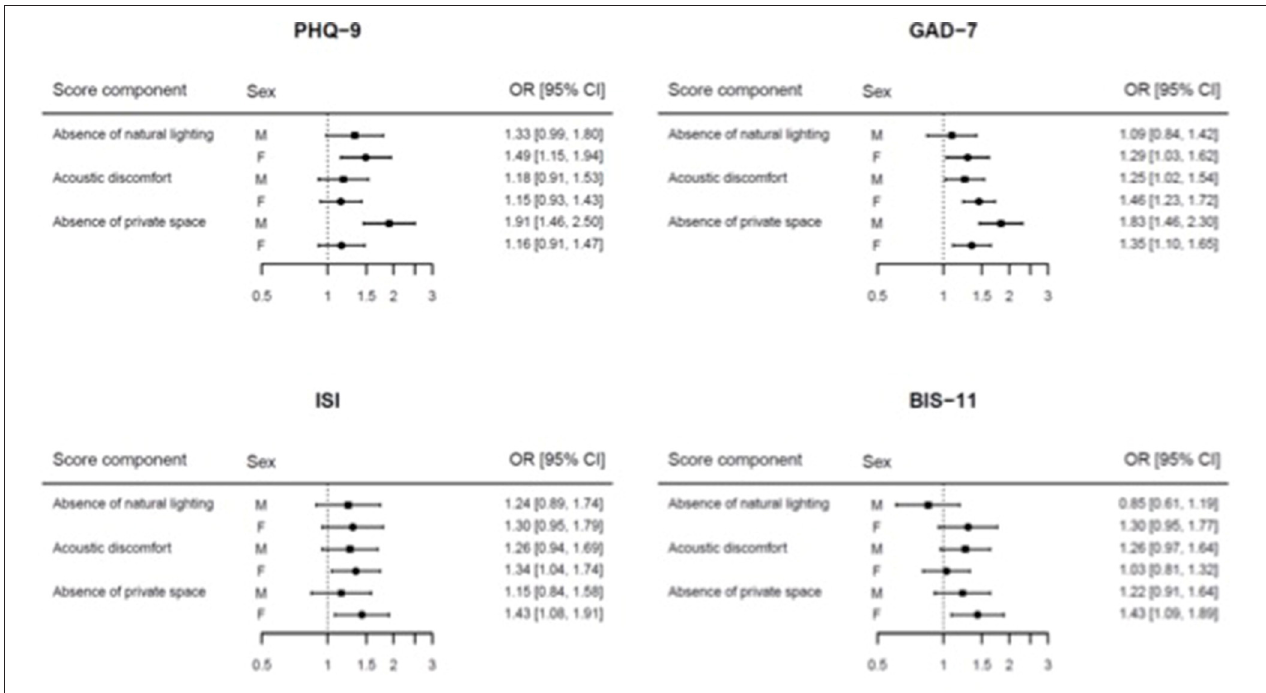
FIGURE 1 | Forest plot of the odds ratio (OR) and their 95% confidence intervals (CI) for the association between three selected components of the quality indoor score and the four mental health